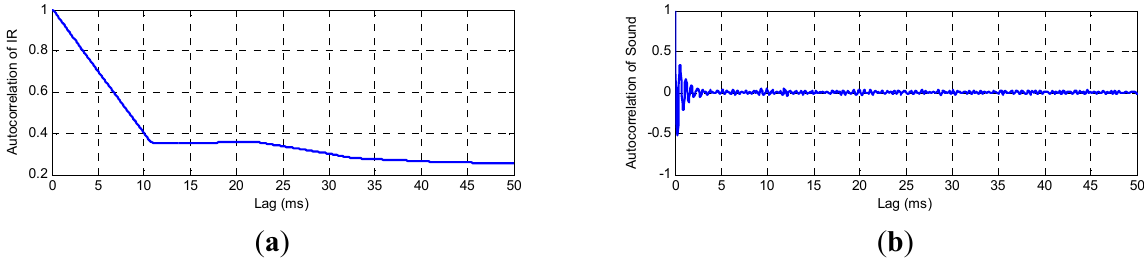
Figure 2. Welding arc emissions